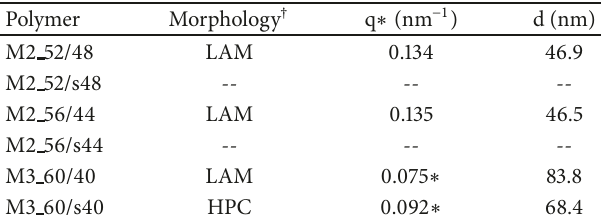
Table 3: Results from the SAXS characterization.